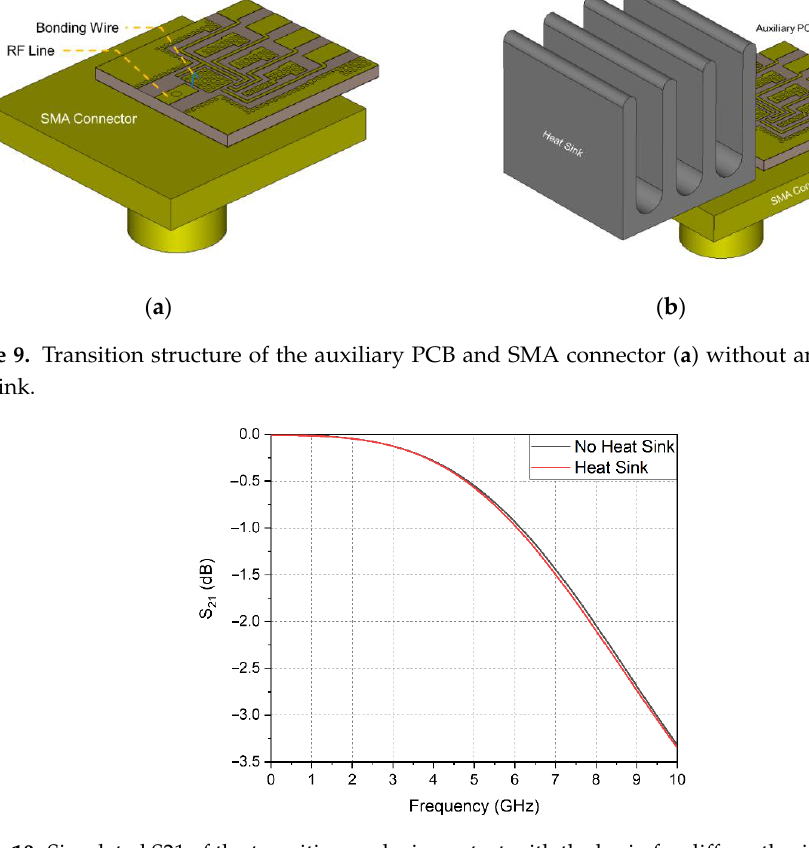
Figure 10. Simulated S21 of the transition probe in contact with the brain for differently sized matching loops with 6.5 GHz resonance.